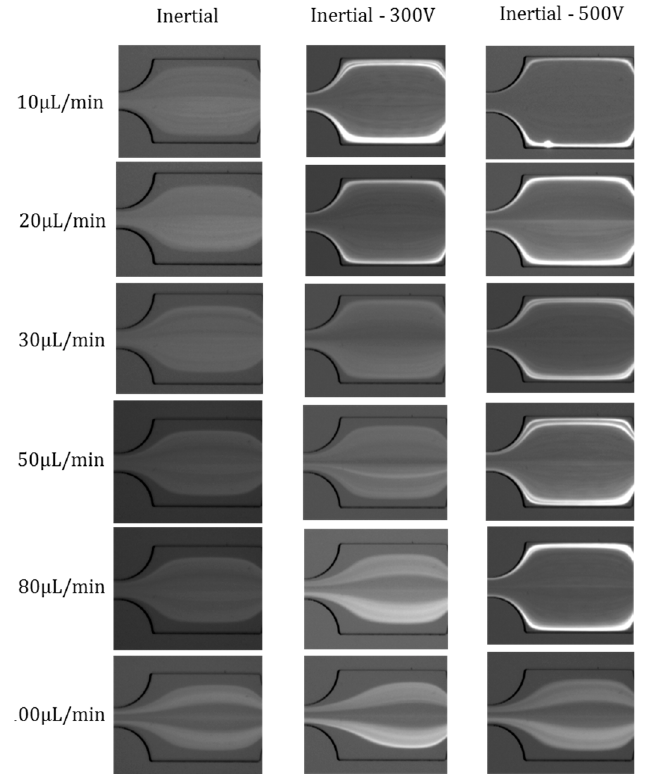
Figure 5. Effects of electric field magnitude on particle distribution (Inertial, Inertial − 300 V, Inertial − 500 V) from flow rate 10 μ L/min to 100 μ L/min. The electric field direction is from the outlet to the inlet.